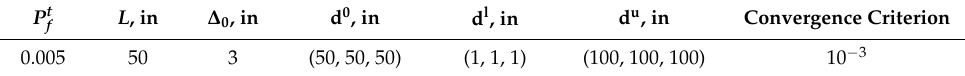
Table 7. Target failure probability and parameters for the reliability analysis and optimization.